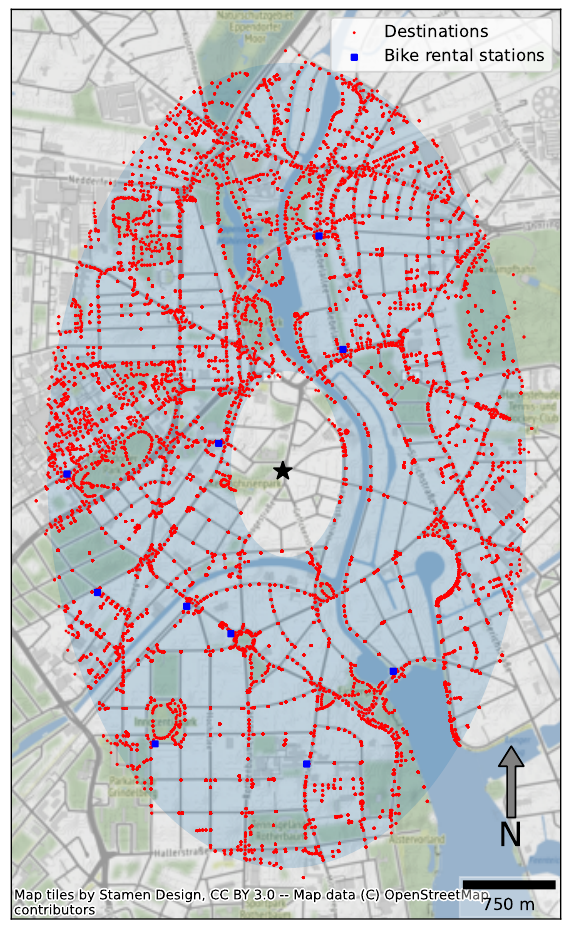
Figure 2. Within the circular simulation area (light blue), agents can travel from the subway station (star) to any one of the available POIs (red dots). A bike rental station (dark blue) is a location at which a Shared Bike can be picked up and dropped